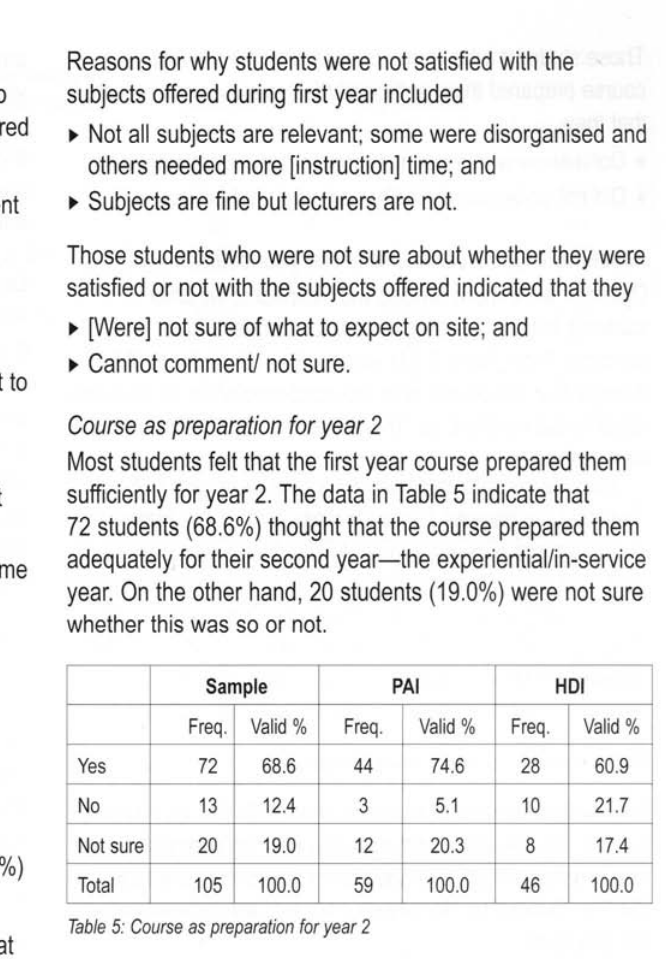
Table 5: Course as preparation for year